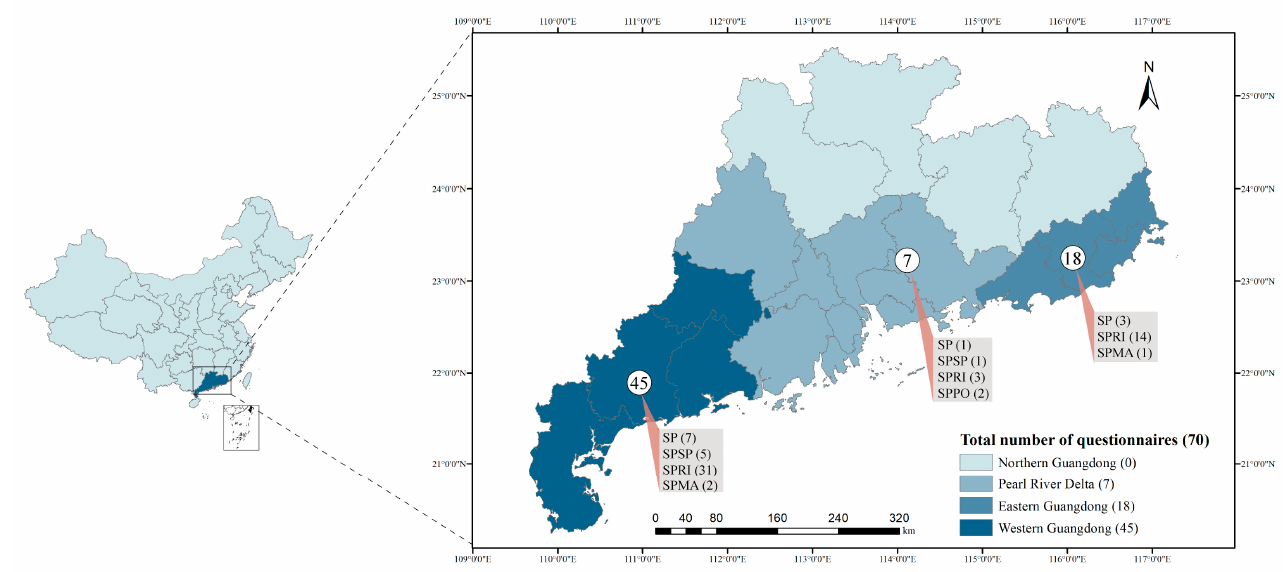
Figure 1. Distribution of sample sites for face-to-face questionnaire survey in Guangdong. SP, sweet potato monoculture; SPRI, sweet potato–rice; SPMA, sweet potato–maize; SPPO, sweet potato–po- tato; and SPSP, sweet potato–sweet potato. Numbers are expressed as the number of questionnaires.